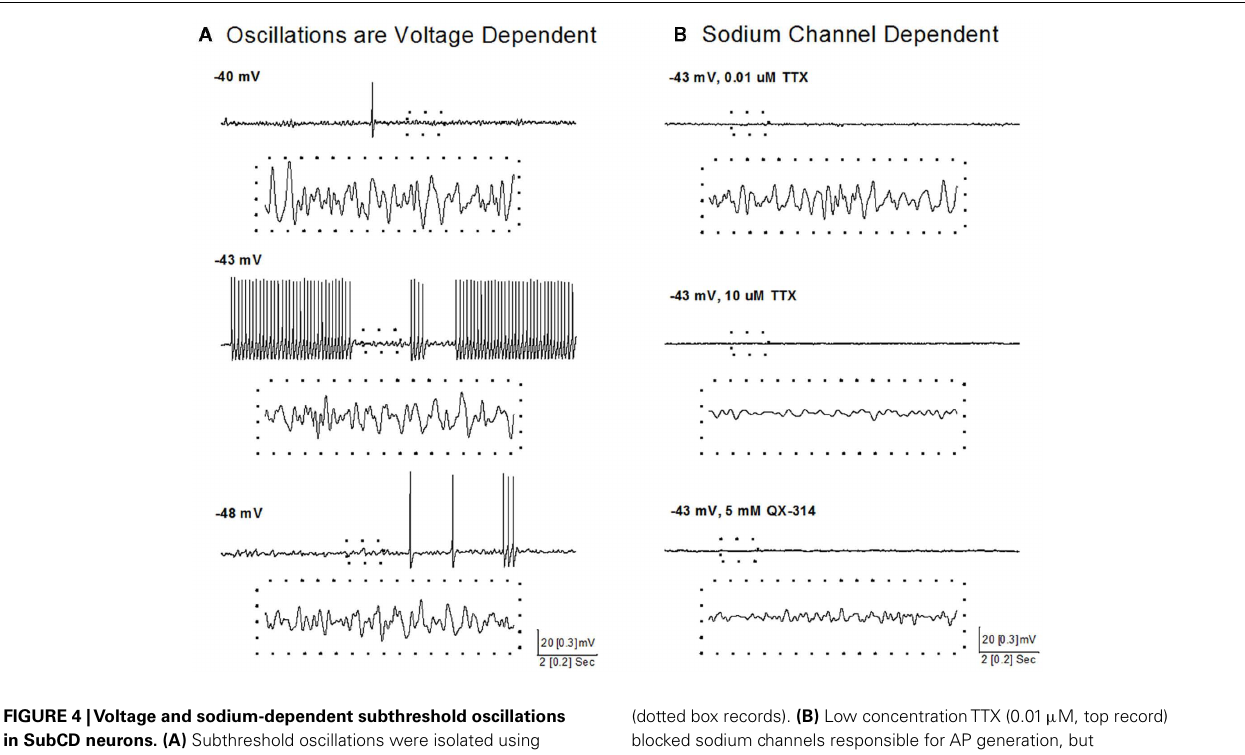
FIGURE 4 |Voltage and sodium-dependent subthreshold oscillations in SubCD neurons. (A) Subthreshold oscillations were isolated using APV, CNQX, GBZ, and STR, and were observed at membrane potentials below AP threshold (bottom record, − 48mV), between APs at membrane potentials above AP threshold (middle record, − 43mV), and following inactivation of sodium channels underlying APs by further depolarization (top record, − 40mV).The dotted boxes include 1s of recordings (from upper records) that are shown at higher resolution